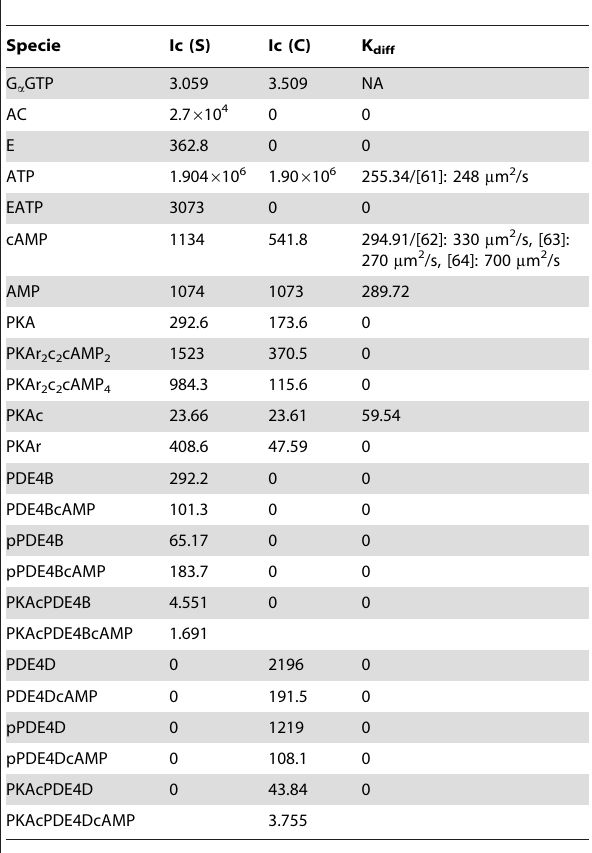
Table 2. Initial concentrations for molecules in the